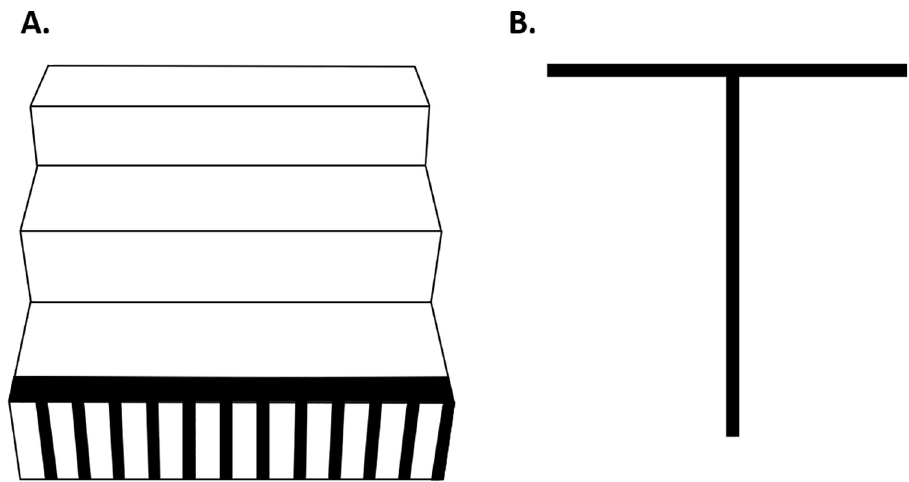
Fig 1. Horizontal-vertical illusions. (A) A version of the stair horizontal-vertical illusion. (B) The original horizontal- vertical illusion. The stair design is characterised by square wave gratings on the step riser and a top edge abutting edge highlighter positioned on the going of the step. The black and white stripes here are characterised by a 70–30% mark space ratio design. In the original horizontal-vertical illusion, the vertical line is perceived to be up to 20% longer than the horizontal despite both lines being of equal